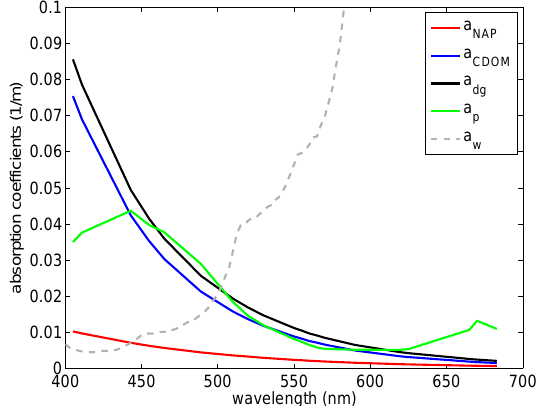
Figure 1. Median inherent optical property (IOP) spectra from NO- MAD data set and absorption spectrum of pure water in gray. In the visible spectrum, CDOM absorption is strongest in the blue and de- creases exponentially with increasing wavelength. The absorption spectrum of pure water is 0.0434m − 1 at 530nm and increases to 0.6m − 1 at 700nm, exceeding the axis limits shown here (Pope and Fry, 1997). The absorption spectrum of particles (including phyto- plankton), a p , absorbs strongly in the red wavelengths compared to NAP and